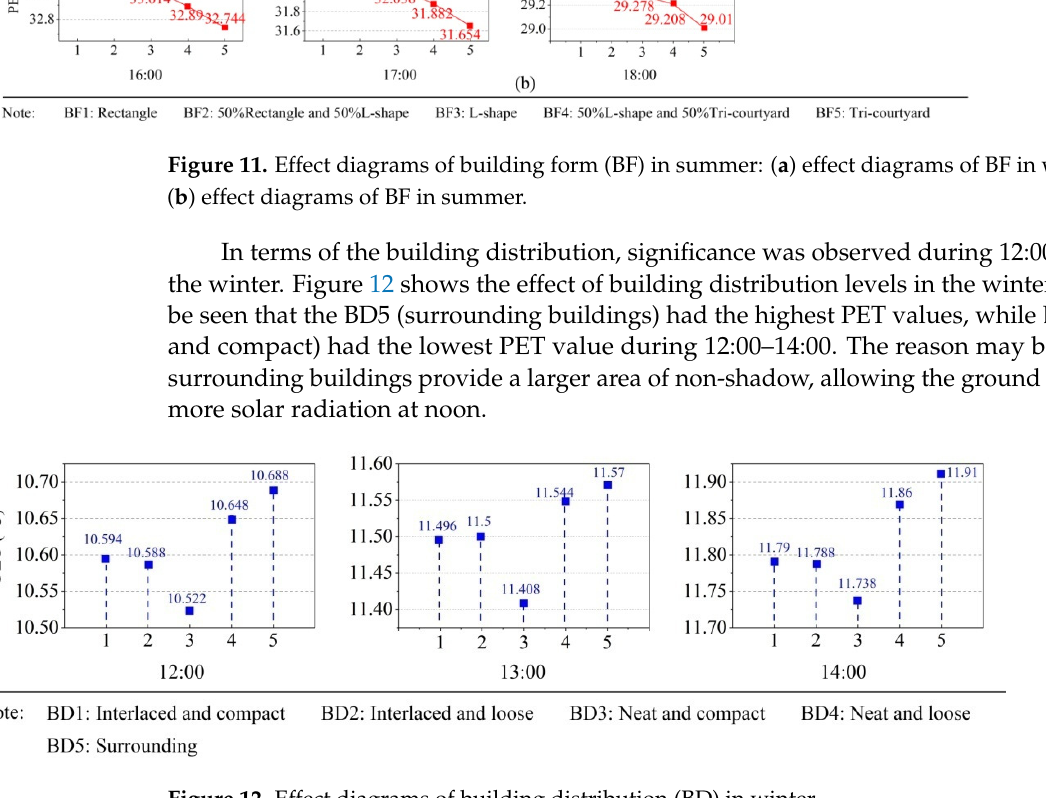
Figure 12. Effect diagrams of building distribution (BD) in winter.